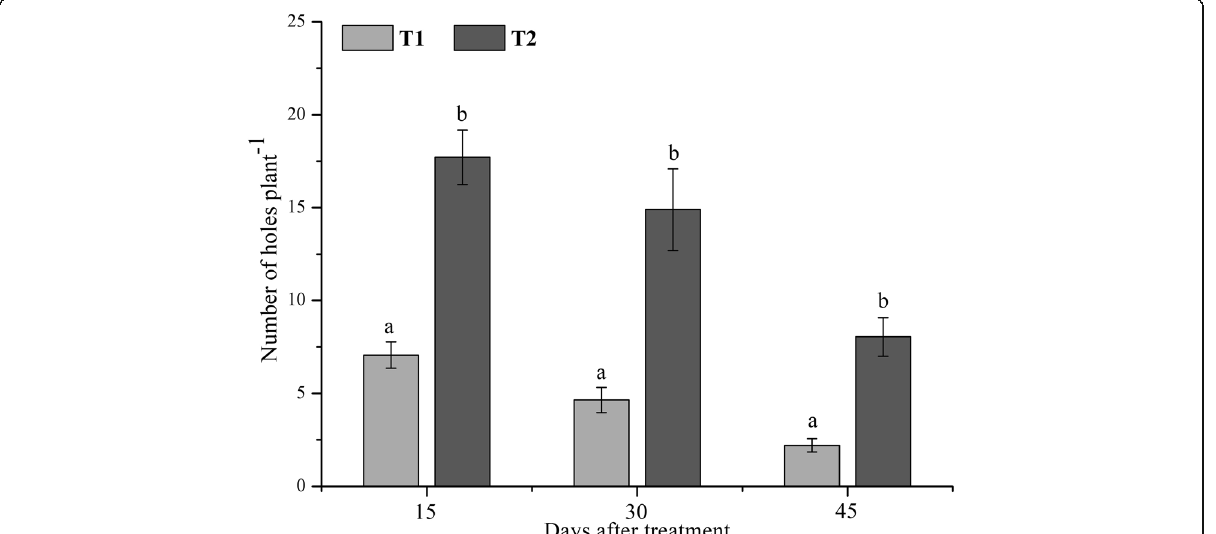
Fig. 2 Effect of biocontrol-based IPM and farmers ’ practice on a number of holes on cabbage leaves per plant by DBM at 15, 30, and 45 days after treatment. Different letters on the top of error bars indicate statistically different values for different treatments using Tukey ’ s test ( P < 0.05).